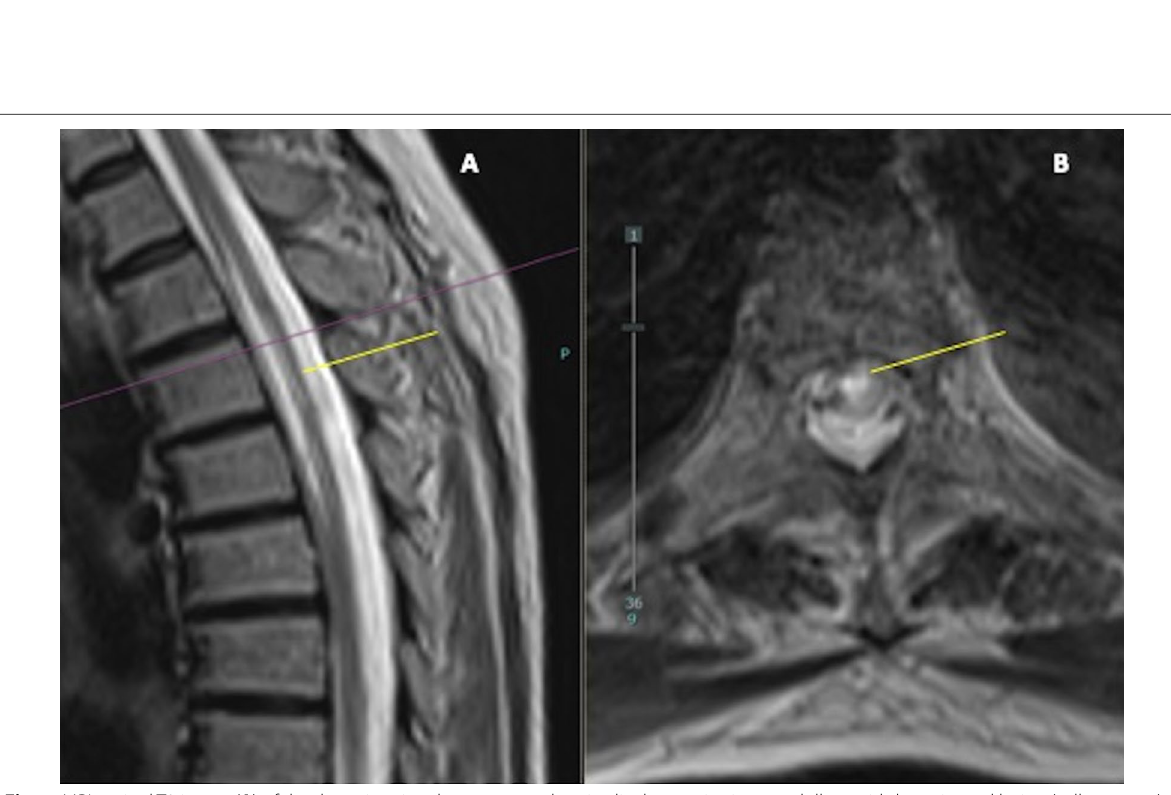
Fig. 5 MRI sagittal T2 image ( A ) of the thoracic spine demonstrate a longitudinal extensive intramedullary mid-thoracic cord lesion (yellow arrow), with a corresponding focus that is as bright or brighter than CSF on the axial images ( B ) (yellow